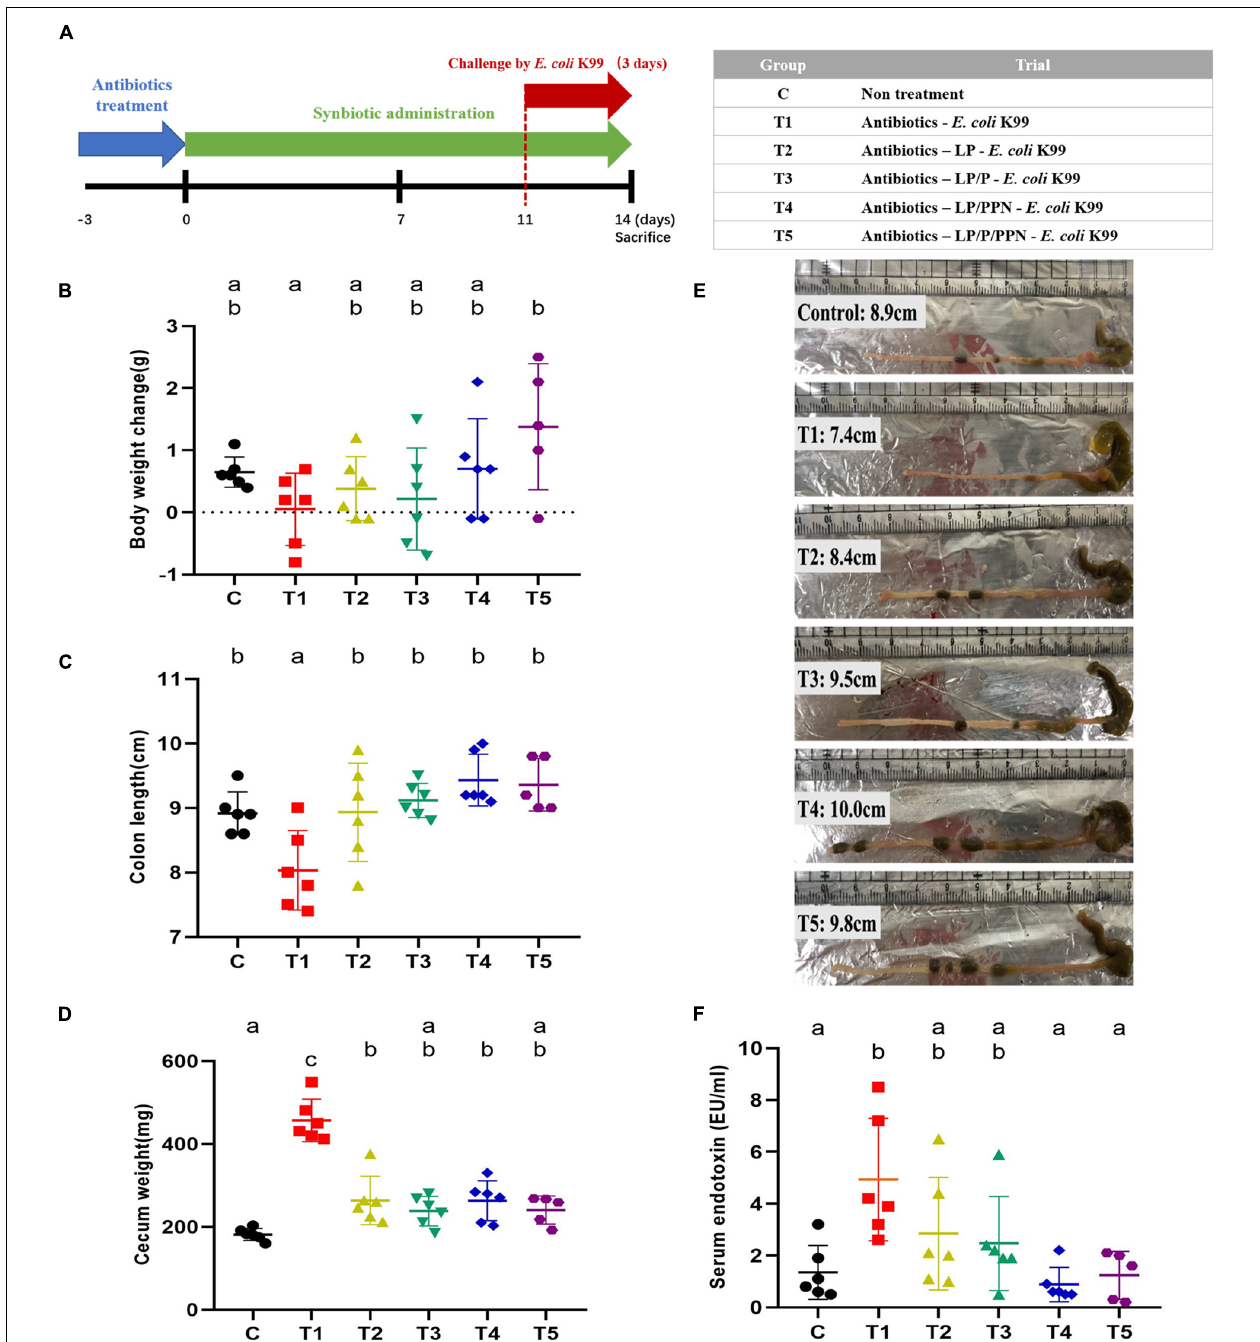
FIGURE 2 | In vivo experiment schedule and physiological changes of dysbiosis-induced mice upon pro-/synbiotics after pathogen Escherichia coli infection. Experiment schedule and group information (A) . Individual body weight changes from start to end of the experimental period in each group (B) . Colon length (C) and cecum weight (D) were measured at the end of the experiment, and their representative picture after dissection (E) . Serum endotoxin (LPS) level per group was measured using sera samples (F) . One-way ANOVA with Tukey’s post hoc test was used to determine significant differences among groups. Different superscript letters indicate statistical significance ( p <